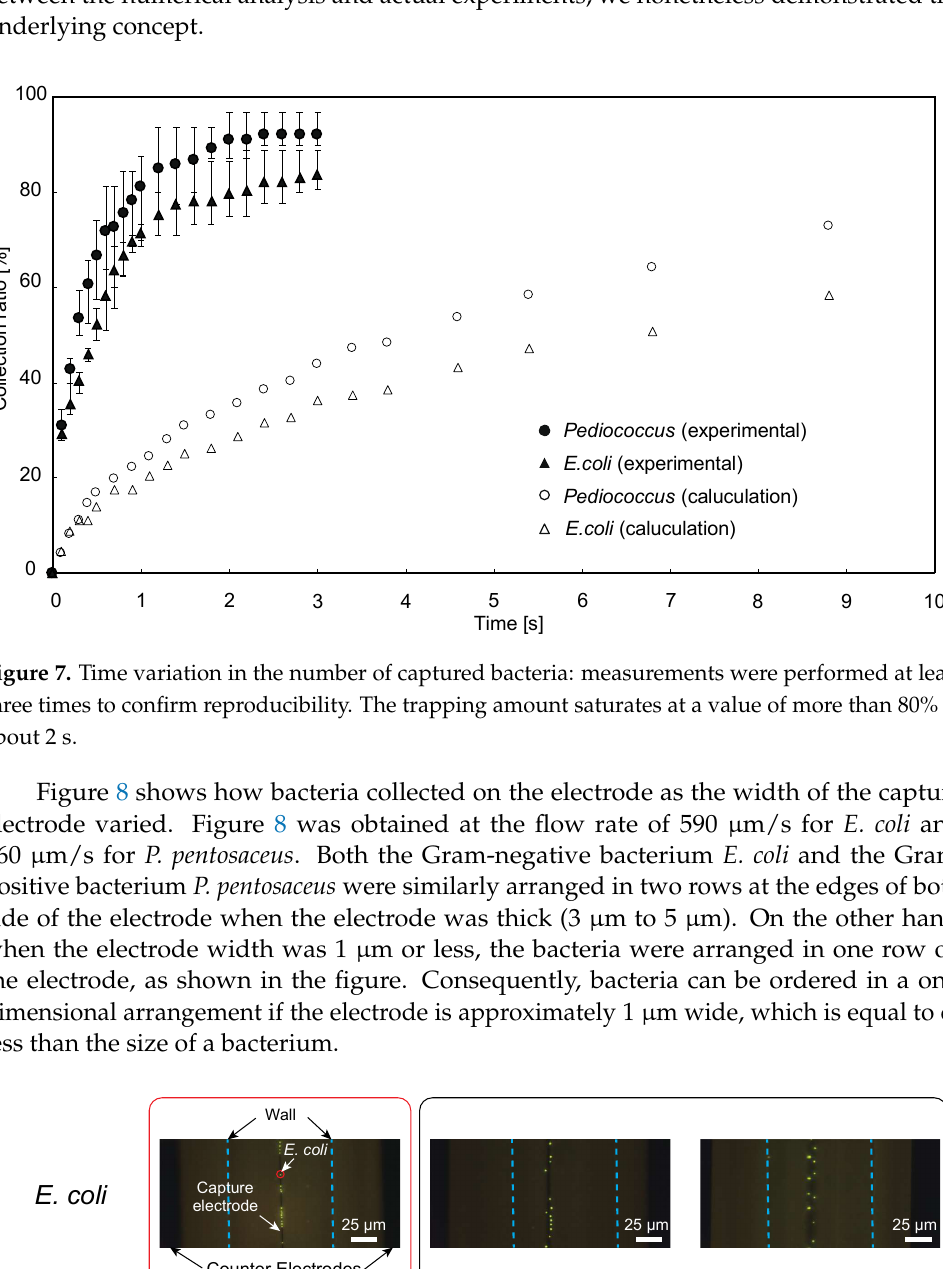
Figure 8. Electrode width dependence of the captured bacteria: Both E. coli at a flow rate of 590 μm/s and P. pentosaceus at a flow rate of 590 μm/s are similarly arranged in one row when the electrode was about 1 μm or less in width and are arranged in two rows at both edges of the electrode when the electrode was thick (3 μm to 5 μm).